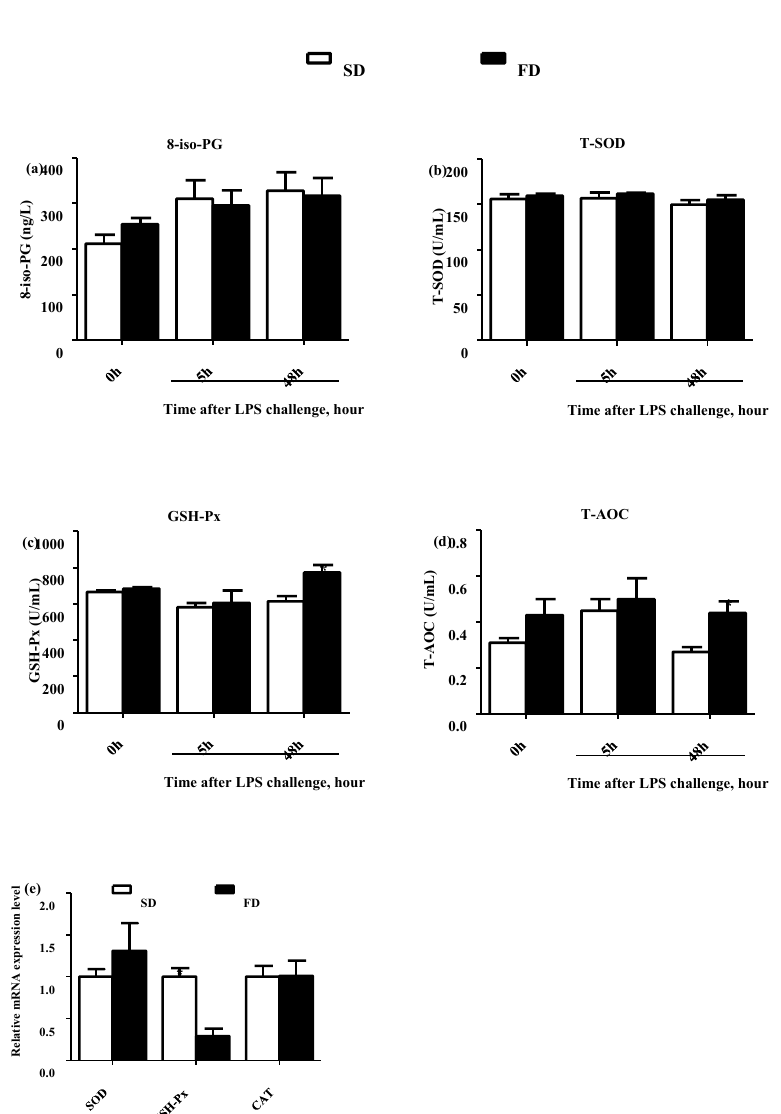
Figure 1. Effect of maternal diet with fish oil on the oxidative stress status in the plasma and livers of piglets. 8-iso-PG concentration ( a ), T-SOD activity ( b ), GSH-Px activity ( c ) and T-AOC ( d ) in plasma collected from piglets on 14 d (14 d), 14 + 5 h after LPS challenge (5 h), and 14 + 48 h after LPS challenge (48 h) were determined. Relative expression levels of SOD, GPx, and CAT mRNA in livers of piglets after 48 h treatment of LPS collected from sows fed different diets ( e ) were determined by real-time PCR. Values from plasma are means ( n = 6), and values from livers are means ( n = 4), with their standard errors represented by vertical bars. SD = soybean oil diet, FD = fish oil diet.